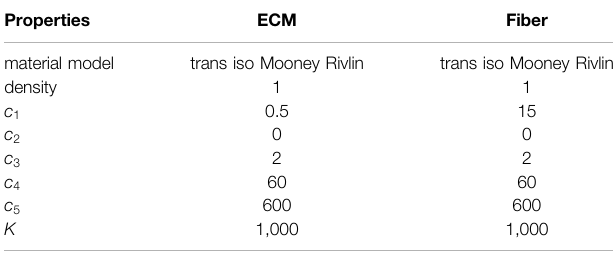
TABLE 1 | Material properties for ECM and fi bers in the FE models of the muscle fi ber bundle. Properties were unchanged across all iterations.